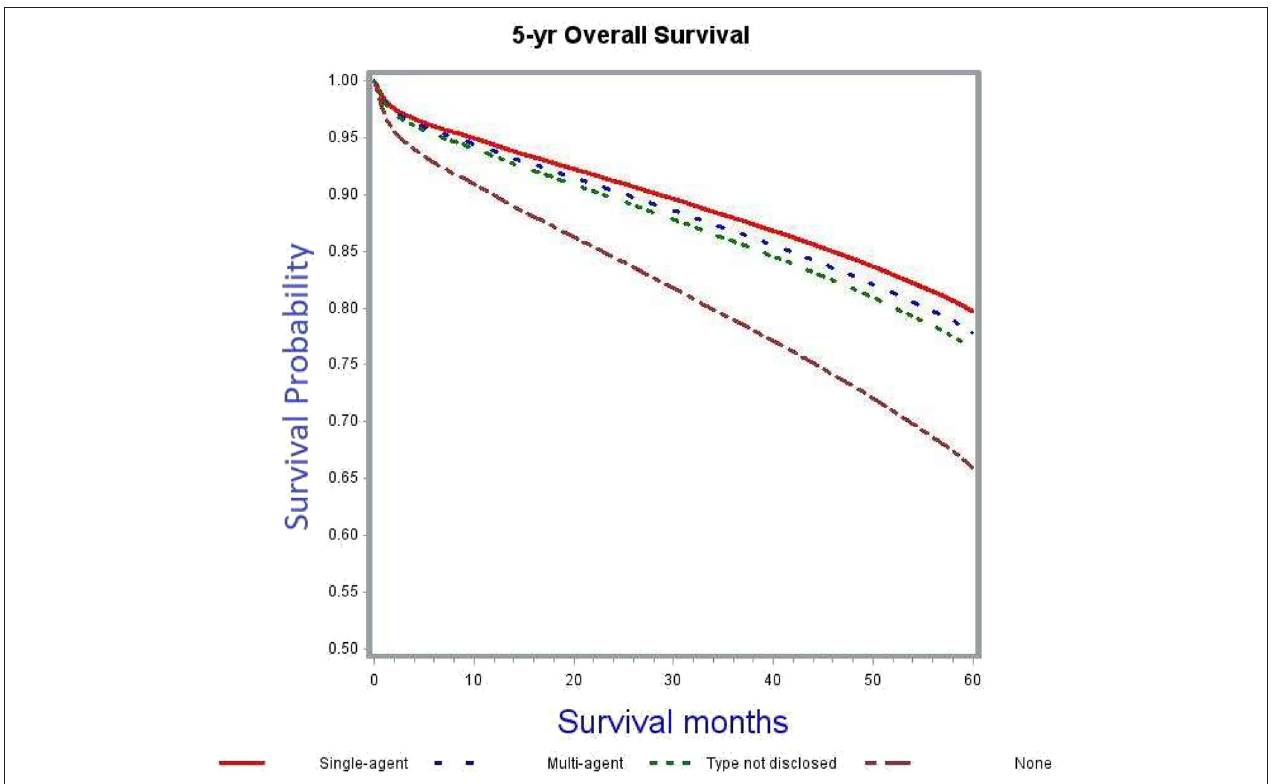
FIGURE 2 | Adjusted survival curves stratified by adjuvant chemotherapy ( p < 0.0001).